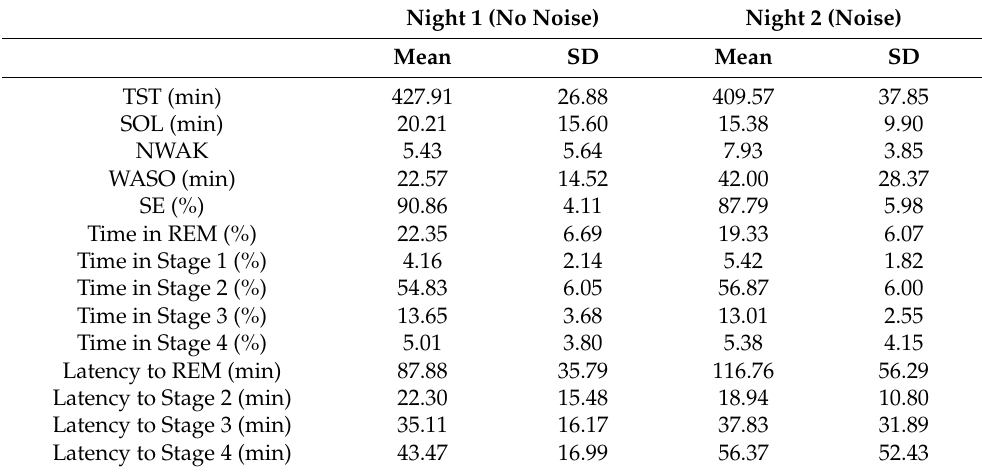
Table 4. Objective sleep continuity and architecture comparisons between noise and no noise nights ( n =